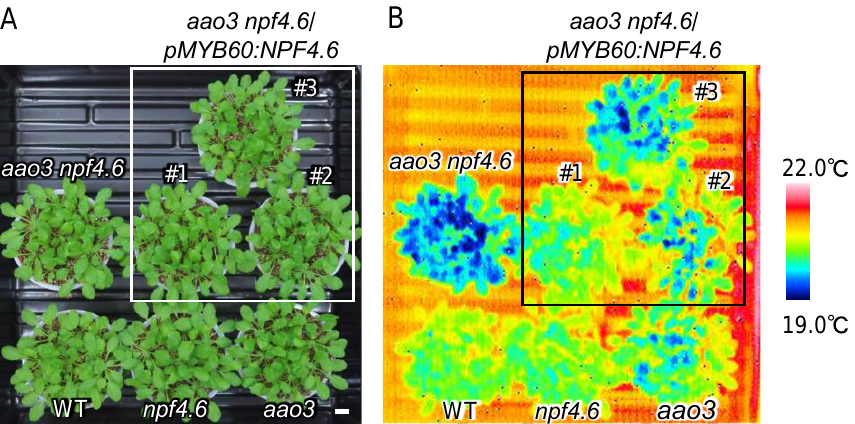
Figure 3. Guard-cell specific expression of NPF4.6 in the aao3 npf4.6 double mutant background. ( A ) Wild type (WT), npf4.6-1 ( npf4.6 ), aao3-4 ( aao3 ), aao3-4 npf4.6-1 ( aao3 npf4.6 ) and three independent lines (#1-3) of aao3-4 npf4.6-1 that express wild-type NPF4.6 specifically in the guard cells ( aao3 npf4.6 / pMYB60:NPF4.6 ). Plants (approximately 1 month old) were grown under a day and night (10 h light/14 h dark) cycle. Scale bar = 1 cm. ( B ) Leaf surface temperature of plants in ( A ) observed by a thermal imaging camera.